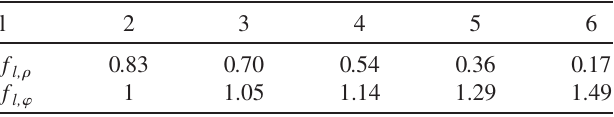
TABLE I. Factors f correcting the expanded values of the radial measurement (cid:1) and the azimuthal measurement ’ specific to the Hall probe used